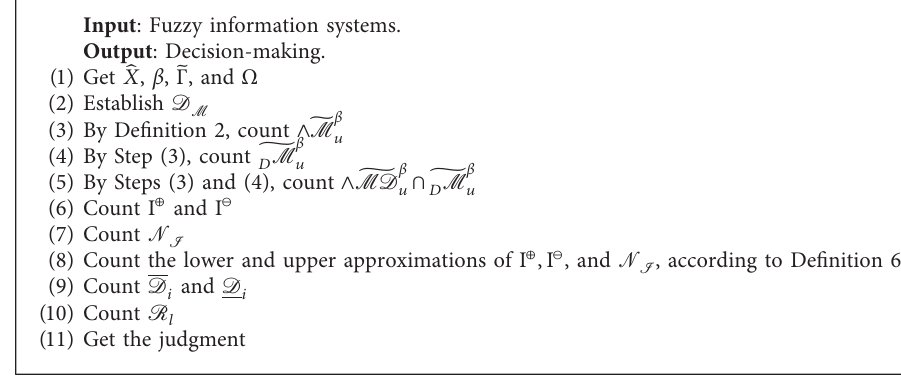
A LGORITHM 1: Algorithm for